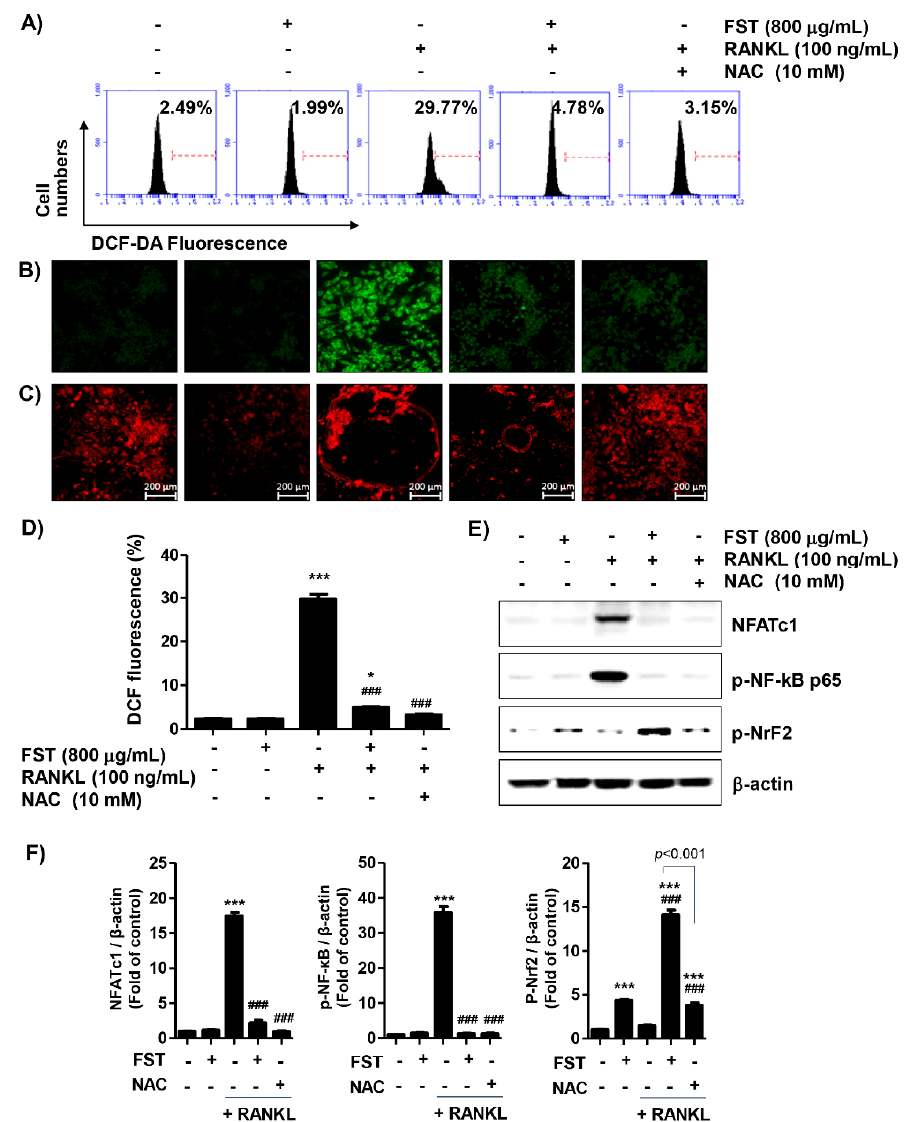
Figure 6. Effect of FST on RANKL-induced reactive oxygen species (ROS) generation in RAW 264.7 mouse macrophage-like cells. Cells were co-treated with 100 ng/mL RANKL for 1 h in the presence or absence of 800 μ g/mL FST or 10 mM NAC. ( A , D ) Cells were stained with 5,6-carboxy-2 ′ ,7 ′ -dichlorofluorescein diacetate (DCF-DA) and DCF fluorescence was measured by flow cytometry. Results are means of two independent experiments. ( B ) After staining with DCF-DA, images were obtained using a fluorescence microscope. Images are representative of at least three independent experiments. ( C ) Cells cultured under the conditions used to induce osteoclast differentiation were fixed and stained for F-actin ring with FITC-phalloidin solution and imaged under a fluorescence microscope. Representative photographs of the morphological changes observed are presented. ( E ) Cellular proteins were isolated from cells and the expression of NFATc1, phospho-NF- κ B and phosphor-Nrf2 by Western blot analysis. β -actin was used as the internal control. The results shown are representative of three independent experiments. ( F ) Statistical analyses were conducted using analysis of variances. * p < 0.05 and *** p < 0.001 when compared to control. ### p < 0.0001 when compared to RANKL treatment. RANKL: receptor of activator of nuclear factor kappa-B ligand; FST: fermented sea tangle extract; NAC: N-acetyl cysteine osteoprotegerin; NFATc1: nuclear factor of activated T cells c1; p- NF- κ B p65: phosphorylated nuclear factor-kappa B p65; p-Nrf2: phosphorylated nuclear factor-erythroid 2-related factor 2; + : cells treated the reagent; -: cells untreated the reagent.